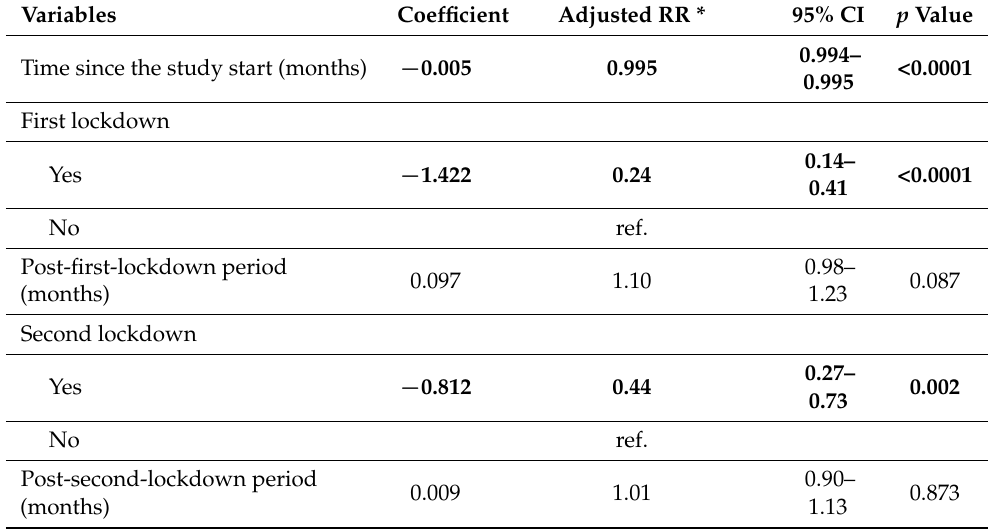
Table 1. Effect of mitigation measures against SARS-Cov-2 on monthly antibiotic prescription rates in children in Germany—results of a generalized linear model with a Poisson distribution, 2010 to 2021.